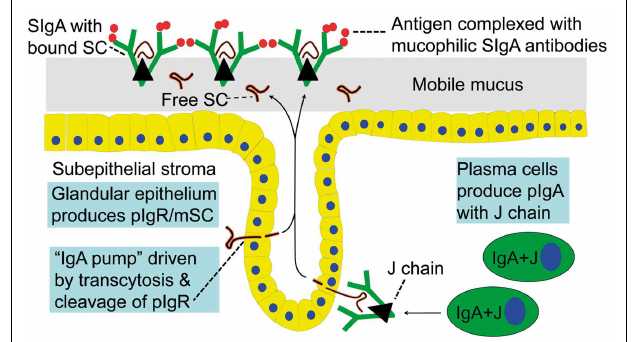
FIGURE 1 | Receptor-mediated epithelial export of polymeric IgA (pIgA, mainly dimers) to provide secretory IgA (SIgA) antibodies . At the mucosal surface, SIgA antibodies together with mucus perform immune exclusion of antigens.The epithelial polymeric Ig receptor (pIgR) is expressed basolaterally, mainly in the intestinal crypts (glands), as membrane secretory component (mSC) and mediates external transcytosis of pIgA (and pentameric IgM, not shown). SIgA is released to the lumen with bound SC by apical cleavage of pIgR, in the same manner as unoccupied pIgR (carrying no ligand) is cleaved to provide free SC. Mucosal plasma cells produce abundantly pIgA with incorporated J chain (IgA + J), which is required for high-affinity epithelial binding of the pIgR ligands. Modified from Brandtzaeg (16).